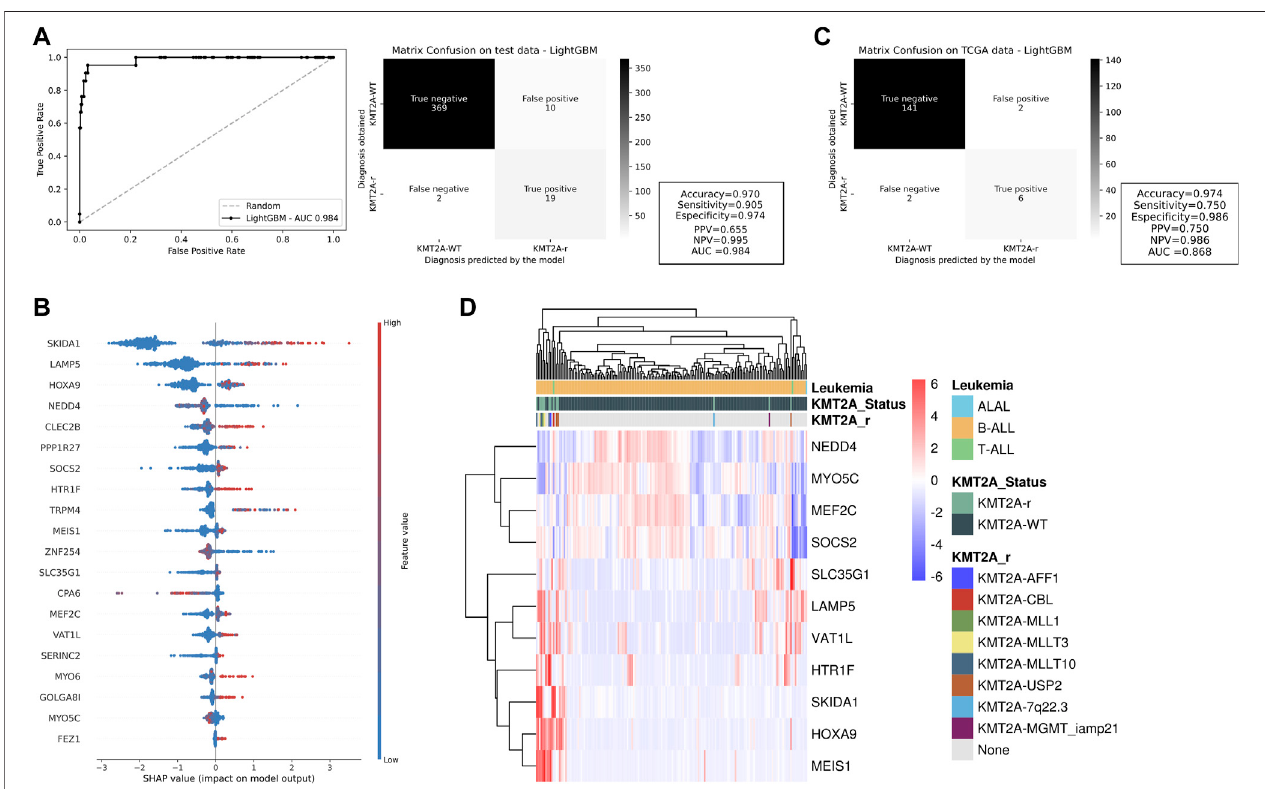
FIGURE 2 | Testing and validation of potential KMT2A -r predictors. (A) ROC curve and confusion matrix of the test cohort for the machine learning model with top 20 genes. The darker the quadrant color, the greater the number of patients. The machine learning performance measures are beside the matrix. (B) Feature contributions of each gene included in this model according to the shapley values. On the x -axis, positive and negative values are correlated with prediction of KMT2A -r and KMT2A -WT, respectively. Each dot represents one patient, colored according to the feature value (red fading to blue means high to low values). (C) The performance measures of our model in an independent cohort (TCGA dataset including AML patients), represented by the confusion matrix, and a (D) heatmap illustratingtheexpressionof11 KMT2A -rpredictorgenesasindicatedbythemachinelearninganalysis.TheclusterizationwasperformedintheFrenchdatasetwithALL